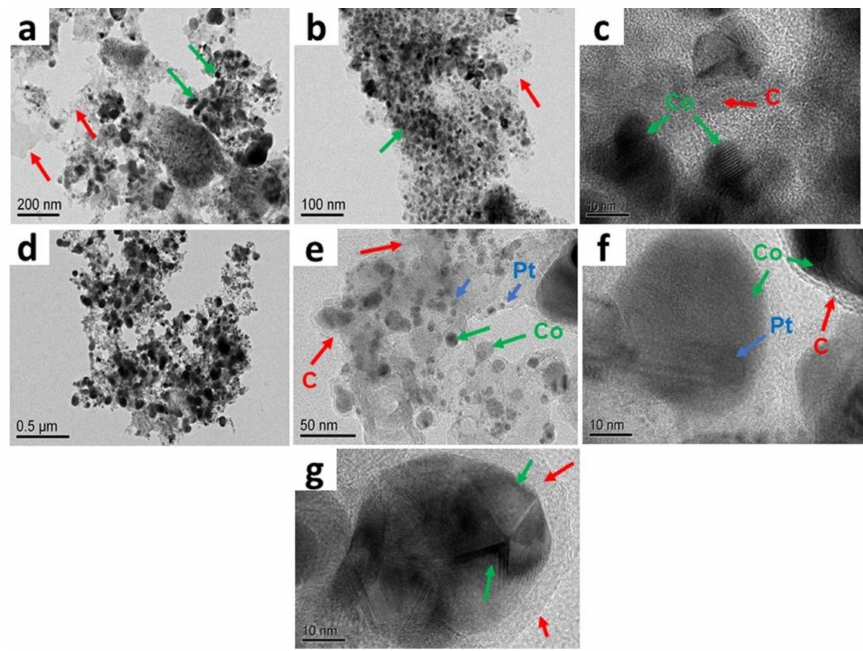
Figure 5. ( a – c ) The TEM and HRTEM images of Co/C and ( d – f ) Pt@Co/C (10:1:2.4). ( g ) High-resolution TEM image of a hexagonally shaped cobalt core carbon shell of Co/C.